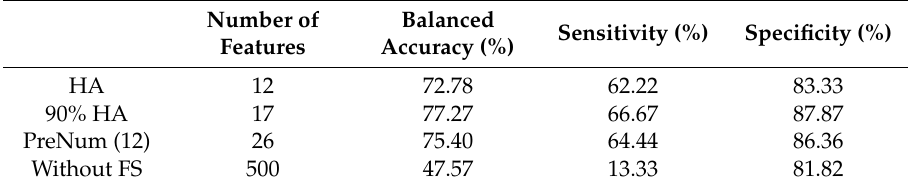
Table 2. Classification performance using three selection variants and performance without any feature selection for TG-Gates_500.